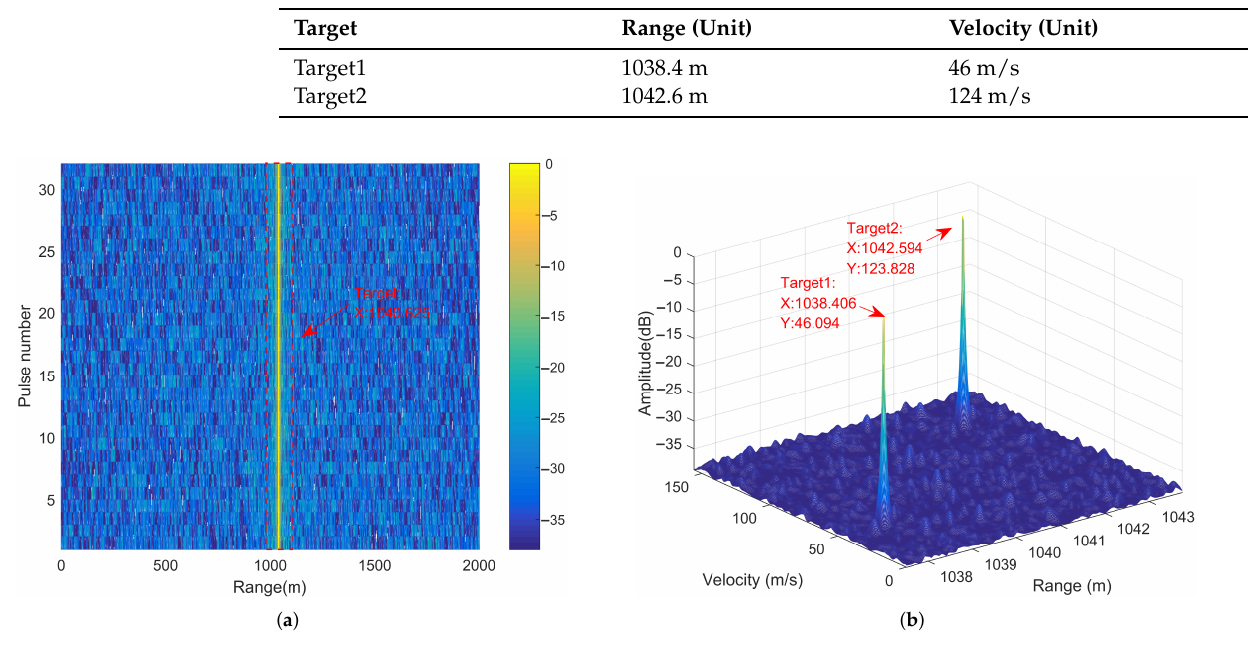
Table 2. Parameters for the moving targets.